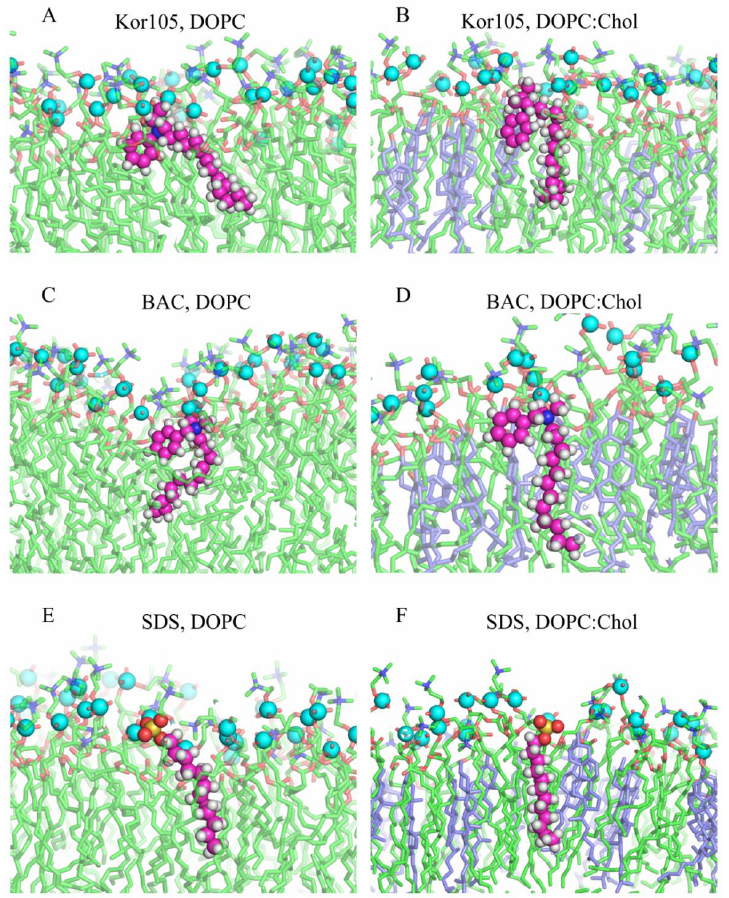
Figure 5. Representative snapshots of Kor105 ( A , B) , BAC ( C , D ), and SDS ( E , F ) conformations in lipid membranes formed from DOPC ( A , C , E ) and the DOPC / Chol 3:2 mixture ( B , D , F ). C, H, N, and S atoms of the ions are shown as magenta, white, blue, and yellow spheres, respectively. Lipids are shown in stick representation, with phosphorus atoms indicated by cyan spheres. DOPC tails are shown as green sticks, cholesterol as blue sticks, O atoms as red sticks, and N atoms of DOPC as blue